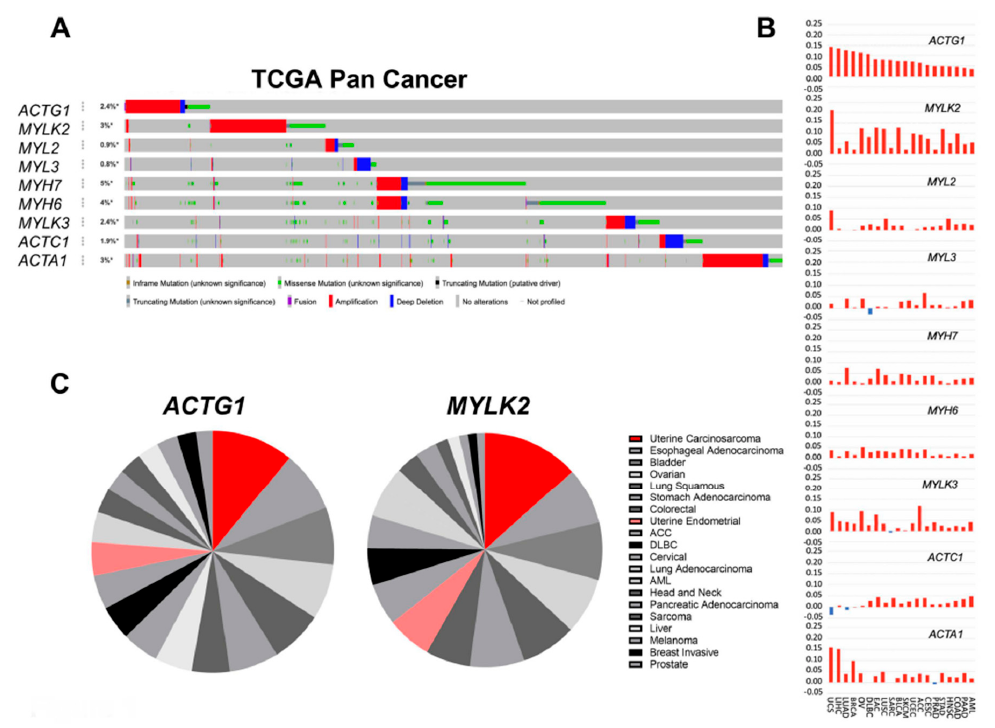
2 Figure 1. Uterine cancers harbor robust dysregulation in ACTG1 and MYLK2 . ( A ) An OncoPrint